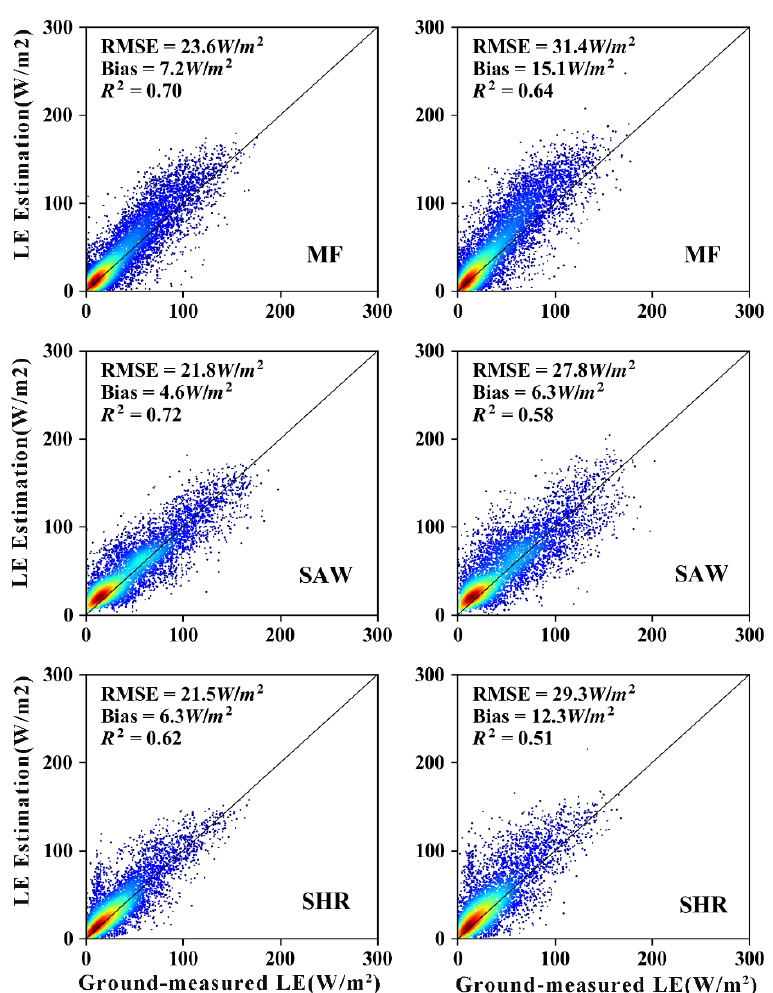
Figure 6. Scatter plots between ground-measured latent heat (LE) ( x -axis, unit: W/m 2 ) and the estimated LE using the simple averaging (SA) method ( y -axis, unit: W/m 2 ) at 240 flux tower sites for different land cover types.